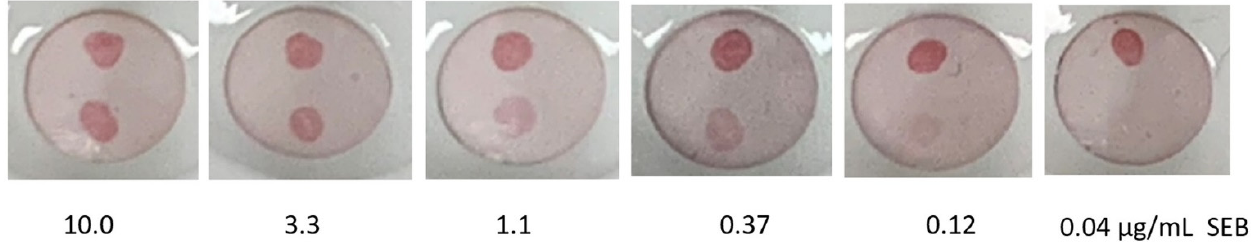
Figure 2. Vertical flow assay for the detection of SEB using A3H2-RZ coated AuNPs. Each Miriad test cartridge was spotted with ACVE-ACVE near the bottom and goat anti-VHH near the top, as a control. After each cartridge was challenged with 100 µL of SEB at the indicated concentration, 100 µL of A3H2-RZ-Bt-sheep-IgG-AuNP was applied to generate the colored spot.